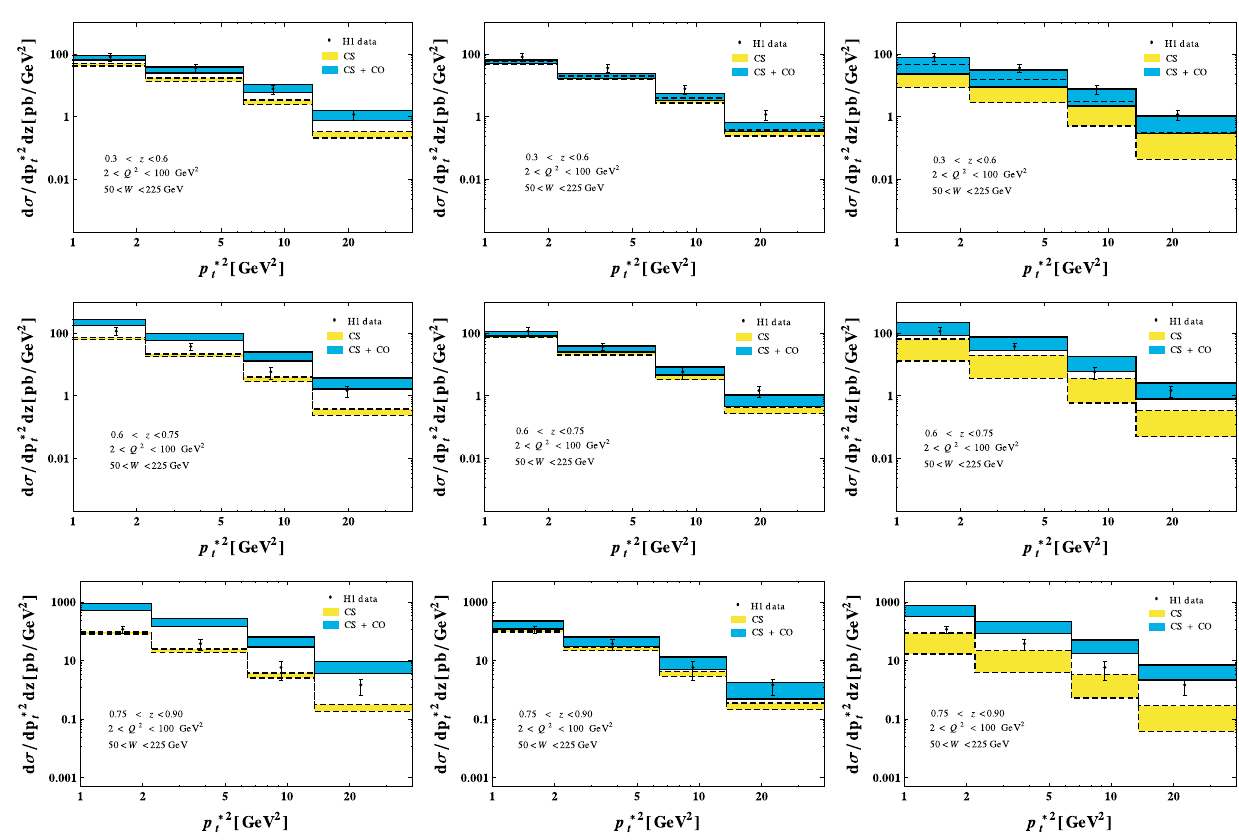
Fig. 17 The double differential cross sections for the J /ψ production in DIS with respect to p (cid:11) 2 t and z . The experimental data are taken from Ref. [49]. The l.h.s., middle, and r.h.s. plots correspond to the LDMEs taken in Refs. [28,30,41],